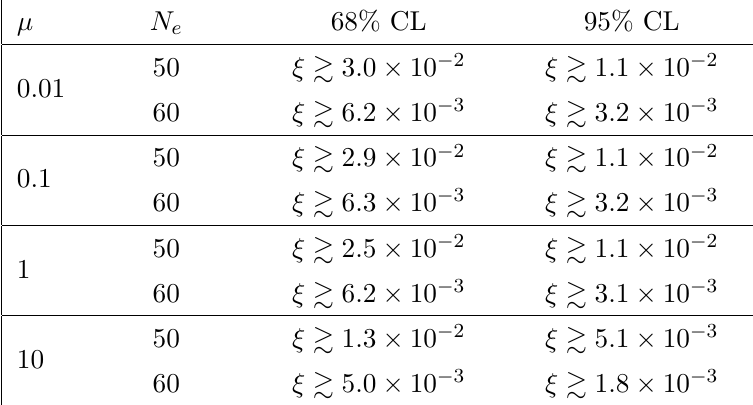
Table 2 . Range of the coupling parameter (cid:24) for which the non- M -(cid:13)ation model is compatible with the 68% or 95% CL constraints of the Planck 2018 data [22] in the r (cid:0) n s